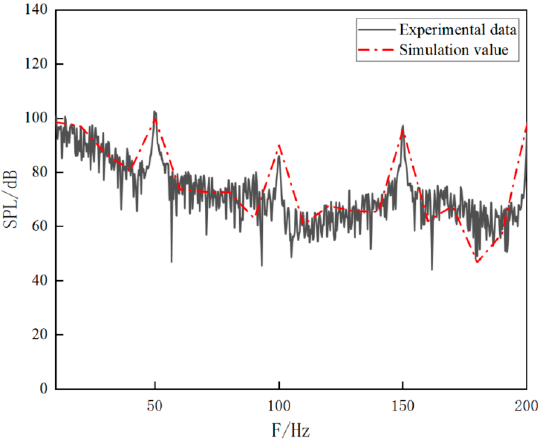
Figure 7. Comparison between simulated and experimental values of imported sound pressure level.